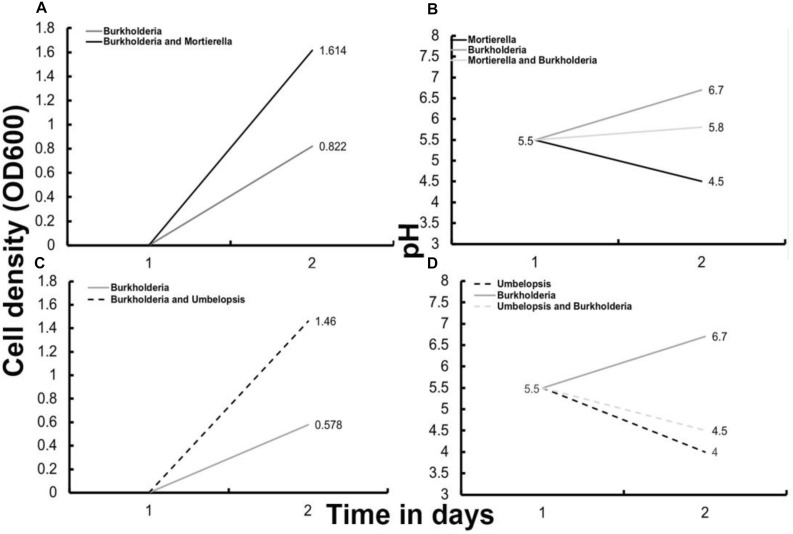
Optical density based growth rates (A,C) and pH (B,D) after 48 h of bacterial growth with and without fungi in liquid P20 media. (A) Optical density growth data for Burkholderia cultured with and without M. elongata. (B) Media pH for Burkholderia cultured with and without M. elongata and M. elongata alone. (C) Optical density growth data for Burkholderia cultured with and without Umbelopsis. (D) Media pH for Burkholderia cultured with and without Umbelopsis and for Umbelopsis cultured alone.